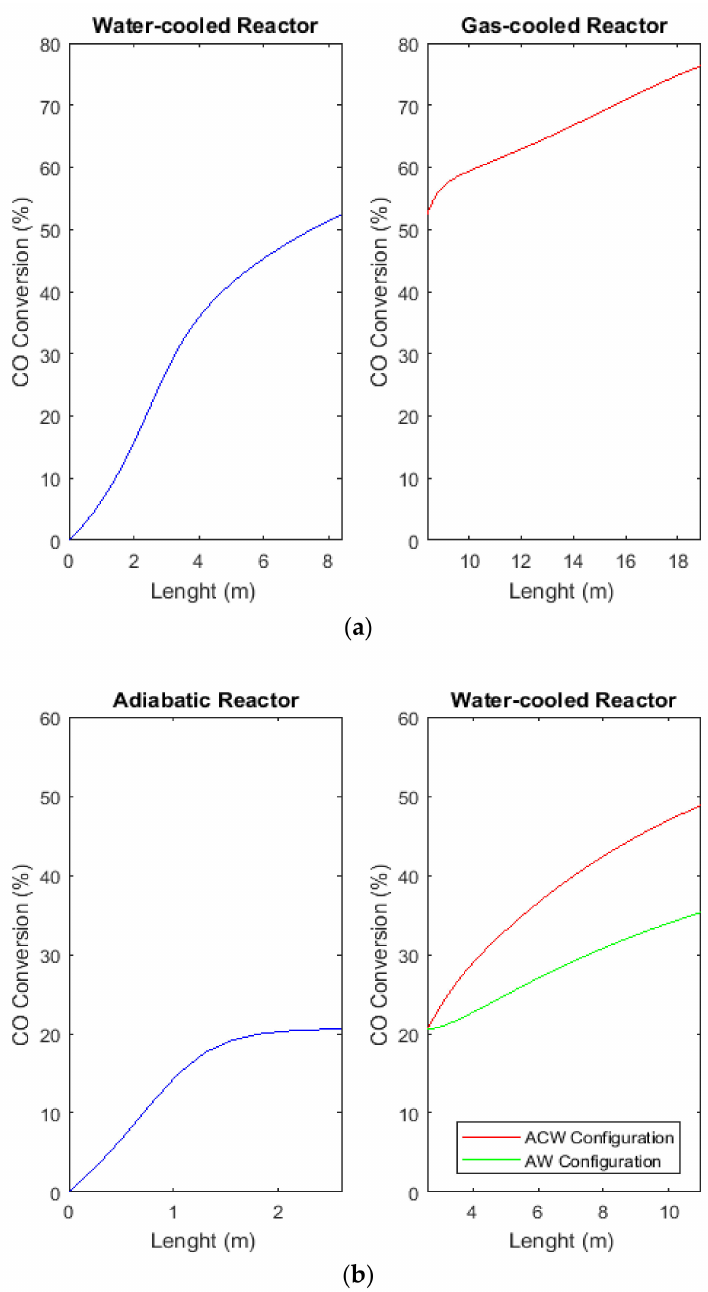
Figure 7. CO conversion along reactors in ( a ) CR configuration; and ( b ) AW and ACW configurations. 2.10. Energy Requirement and Methanol Molar Flow Rate Comparison between CR, AW, and ACW